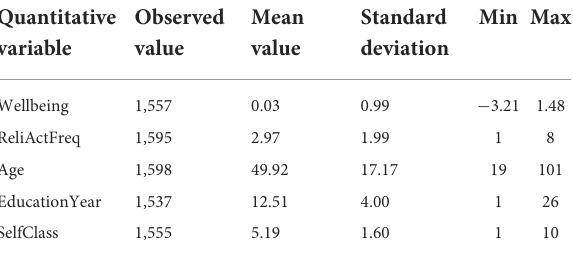
TABLE 3 Regression models of mediating effect.